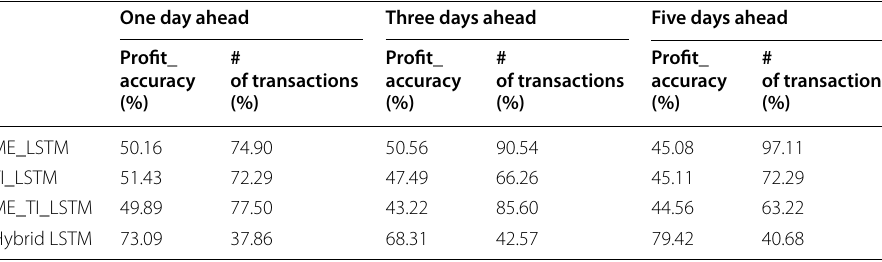
Table 20 Summary of all experiments conducted on the main data set One day